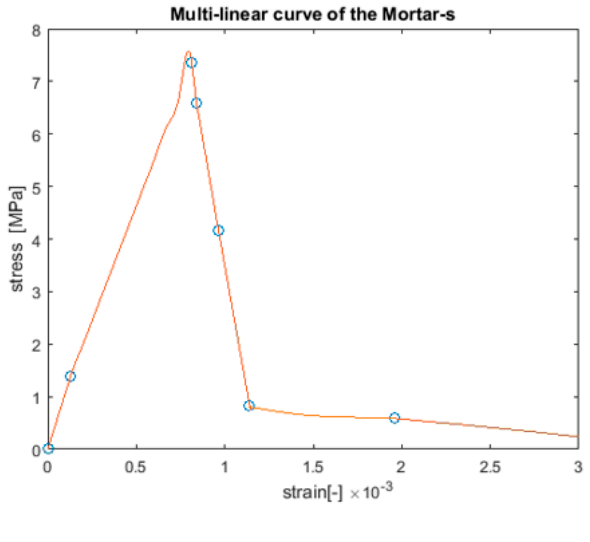
Figure 10. Mortar-s stress–strain curve. Table 6. Mortar-a4 Anm model input parameters.